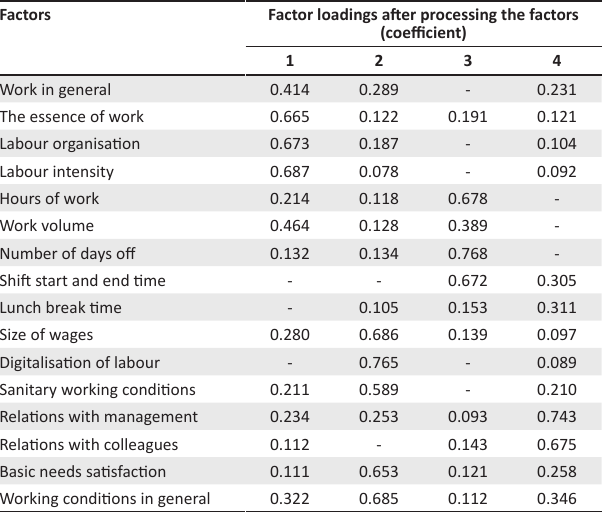
TABLE 1: Factor loadings matrix of work satisfaction. Factors Factor loadings after processing the factors